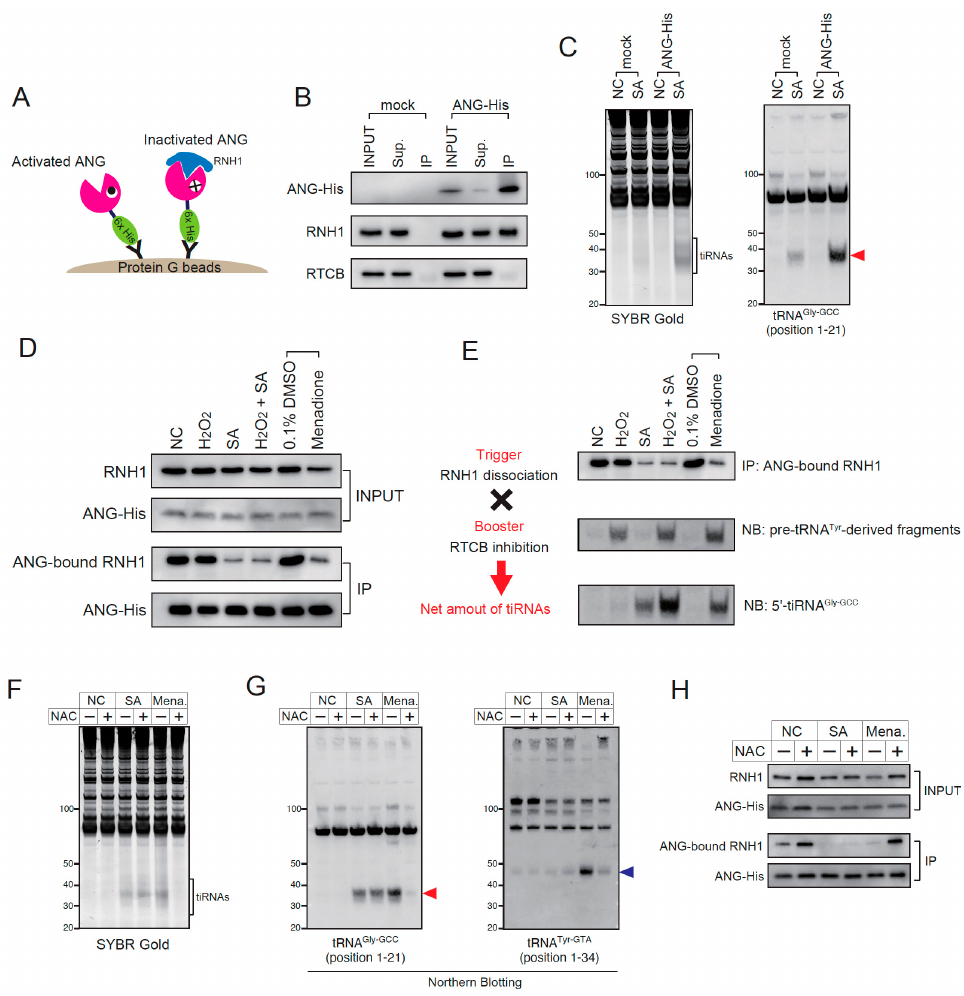
Figure 5. Stress-induced tiRNA production is regulated by both RNH1 dissociation and RTCB inhi- bition. ( A – D ) Evaluation of stress-induced RNH1 dissociation from angiogenin. ( A ) Schematic model of ANG-His pulldown. When ANG was inactivated by RNH1, RNH1 is co-immunoprecipi- tated with ANG-His. Under the condition where ANG is activated, RNH1 is not co-immunoprecip- itated because it dissociates from ANG. ( B ) Efficiency of immunoprecipitation. Overexpressed ANG-His was concentrated by immunoprecipitation. Under non-stress condition, RNH1 is co-im- munoprecipitated with ANG-His. Note that RTCB was not co-immunoprecipitated with ANG-His, suggesting that RTCB does not interact with ANG or RNH1. ( C ) Overexpressed ANG-His is enzy- matically functional. Overexpression of ANG-His enhanced sodium arsenite-induced tiRNA pro- duction. 5 ′ -tiRNA Gly-GCC is indicated by a red arrowhead. Note that ANG-His overexpression does not induce tiRNA production under non-stress conditions, suggesting that ANG-His is completely inhibited by RNH1 under basal conditions. ( D ) ANG-His pulldown under various stress stimuli. ( E ) The net amount of tiRNAs is regulated by both RNH1 dissociation and RTCB inhibition. RNH1 dissociation (trigger), RTCB inhibition (booster) and the net amounts of tiRNAs are evaluated by ANG-bound RNH1, pre-tRNA Tyr -derived fragment and 5 ′ -tiRNA Gly-GCC , respectively. ( F – H ) The ef- fect of N-acetyl-L-cysteine treatment (at 5 mM) on tiRNA production. ( F ) SYBR Gold staining and ( G ) Northern blotting for tRNA Gly-GCC and tRNA Tyr-GTA . 5 ′ -tiRNA Gly-GCC is indicated by a red arrow- head, pre-tRNA Tyr-GTA -derived fragments generated due to RTCB inhibition is indicated by a blue arrowhead. (H) ANG-His pulldown. Note that N-acetyl-L-cysteine treatment did not prevent RNH1 dissociation, suggesting that sodium arsenite-induced RNH1 dissociation is independent of oxida- tive stress. NC, negative control; SA, sodium arsenite; Mena., menadione; NAC, N-acetyl-L-cyste- ine.